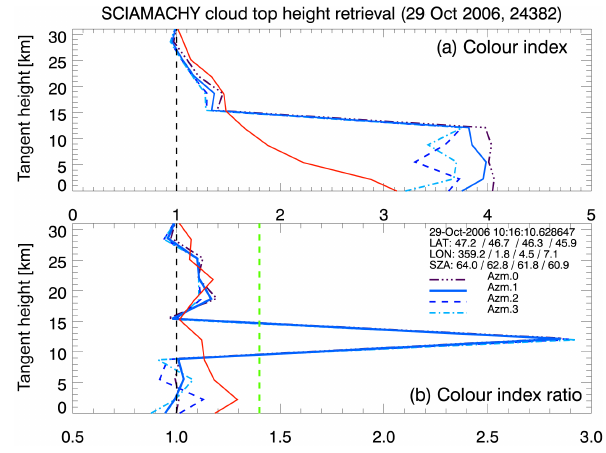
Figure 5. Normalized colour index (a) and colour index ratio (b) of a SCIAMACHY limb state (see Fig. 3) for tangent heights from the ground to 30km. All four limb profiles (AZM 0–3) are measured simultaneously during a limb state. Superimposed is a cloud-free limb profile (red line) from the same orbit (start time 10:38:59UTC, AZM 3). The green dashed line depicts the cloud detection thresh-